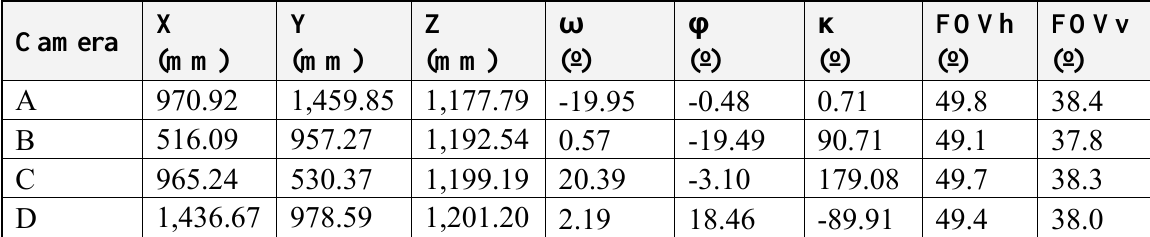
Table 4. Location of the centre of projection of cameras and orientation of the optical axes during the tests. ω , φ and κ are the angles between the optical axes and the object coordinate system. FOVh and FOVv are the horizontal and vertical angle of view of each